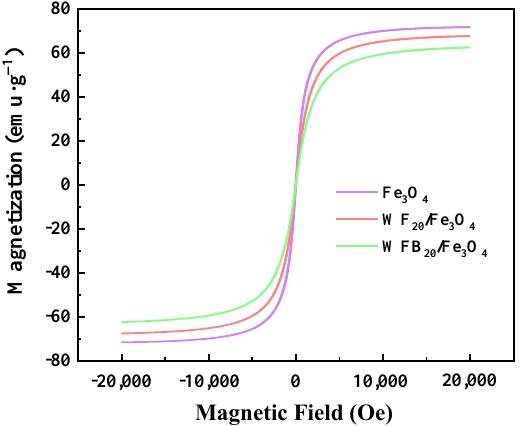
Figure 3. The magnetization curves of Fe 3 O 4 , WF 20 /Fe 3 O 4 , and WFB 20 /Fe 3 O 4 .